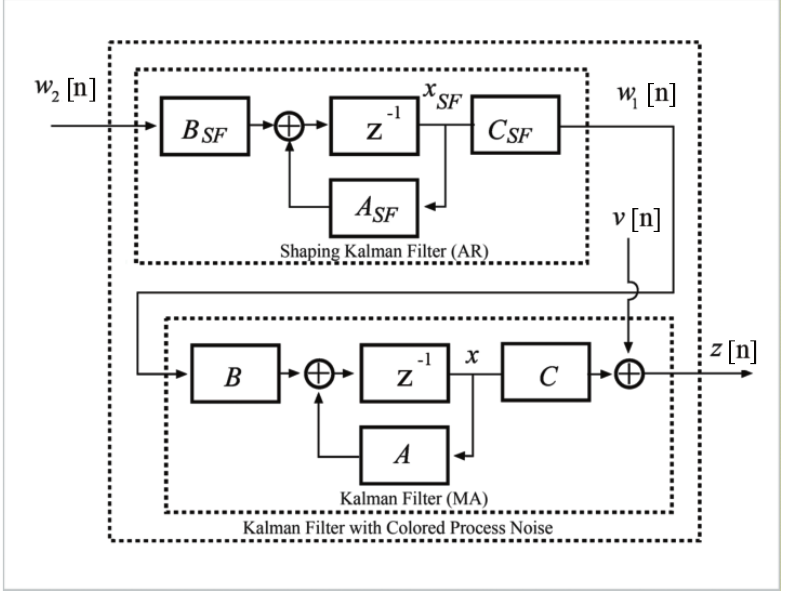
Figure 3. Diagram of modified Kalman Filter with colored state noise process. The physical system corresponds to the standard MA Kalman Filter, with a shaping Kalman filter based on a autoregressive noise process from the spectrum of a periodic Rosenberg glottal flow